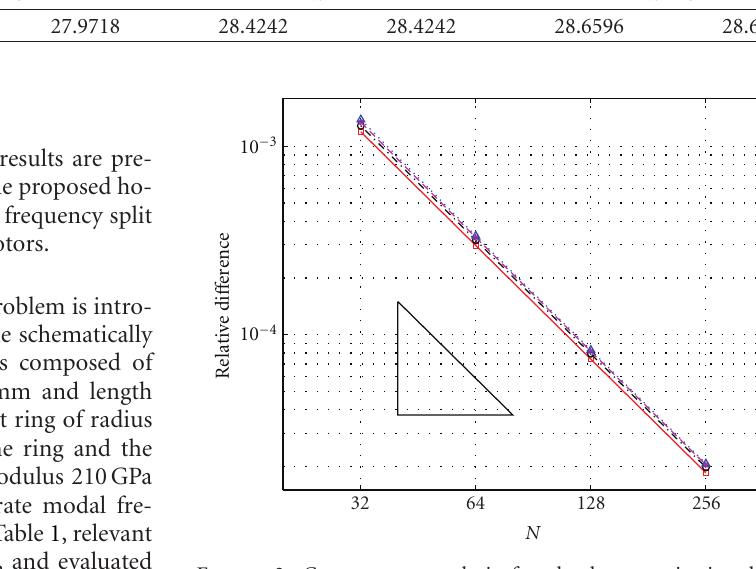
Figure 3: Convergence analysis for the homogenization limit: relative error between modal frequencies evaluated according to the EB model and the HOM model, as a function of the number N of blades. Rotor without imperfections. Modal frequencies relevant to modal numbers l = 1 and — (cid:2) n = 2; – · ◦ n = 3; – – ∗ n = 4; ·· (cid:3) n = 5. The triangle in the figure indicates the quadratic convergence